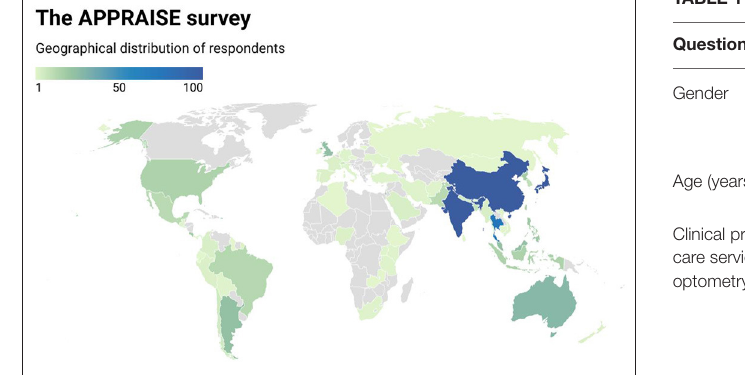
FIGURE 1 | Geographical origin of participants to the APPRAISE